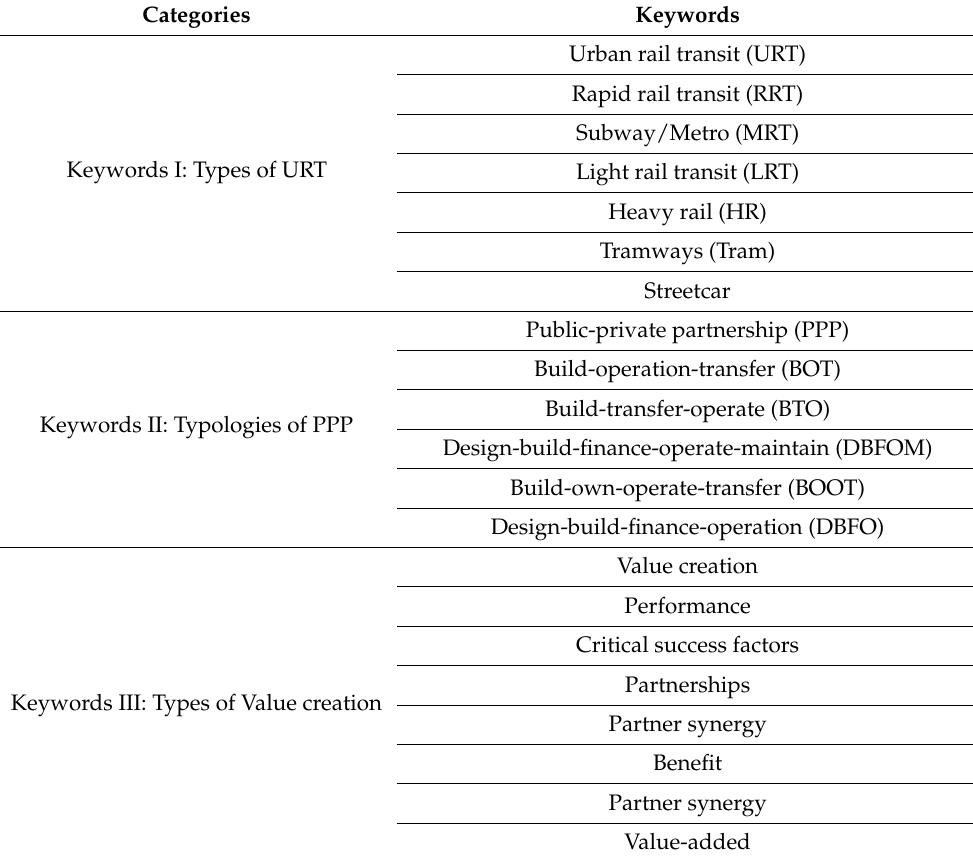
Table 2. List of selected